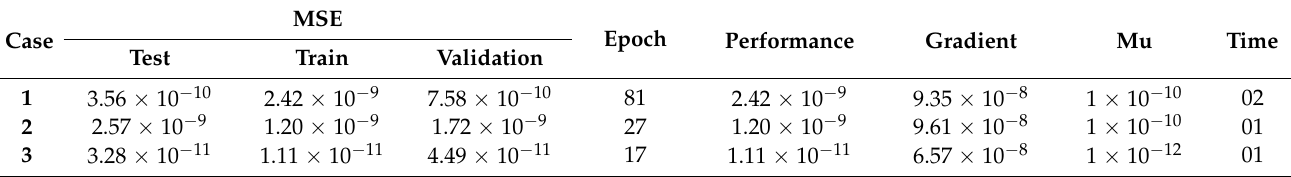
Table 2. SCGNNs procedures for the mathematical form of the FKFS